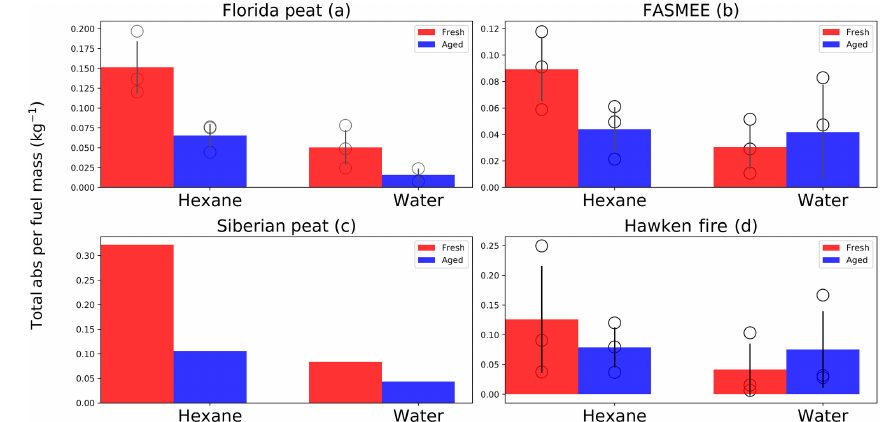
Figure 3. Comparison of total absorbance (Eq. 3) per fuel mass consumed for fresh and aged aerosols in water and hexane extracts, normal- ized to 1mL extraction volumes. Bars, circles, and error bars represent the mean values, individual observations, and standard deviations, respectively. No error bars are given for Siberian peat, because only one experiment was performed with this